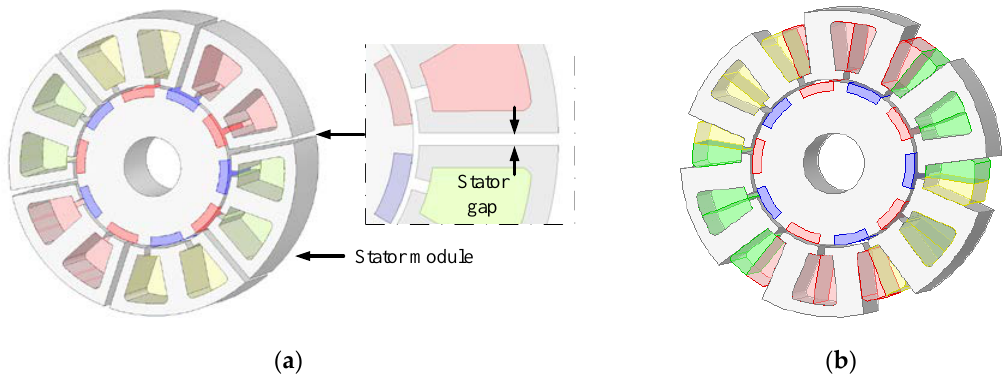
Figure 1. ( a ) Structure of “E” core stator modules. ( b ) Structure of “U” core stator